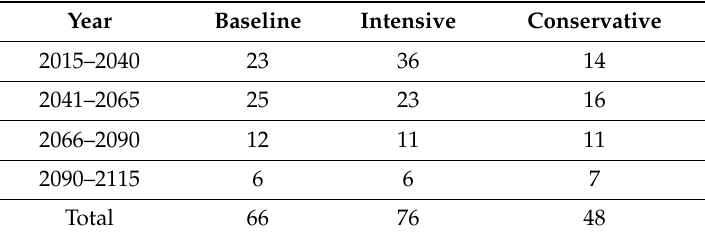
Table 5. Total government income transferred to individuals ($ billion).